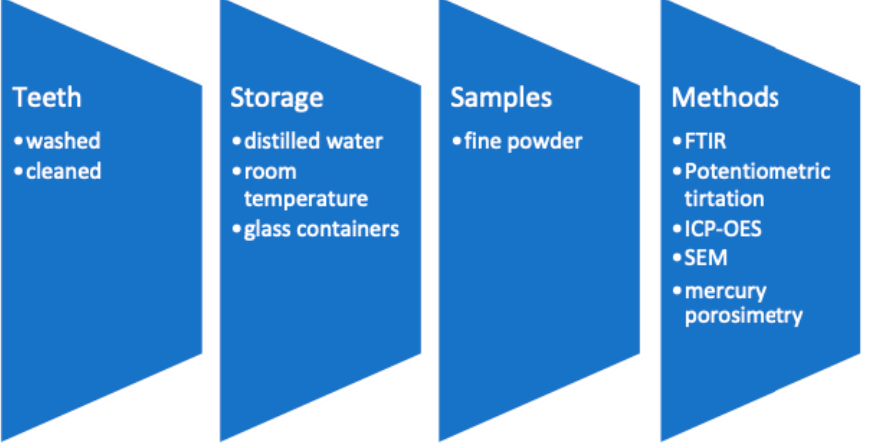
Figure 7. The sequence of procedures in the preparation of samples.